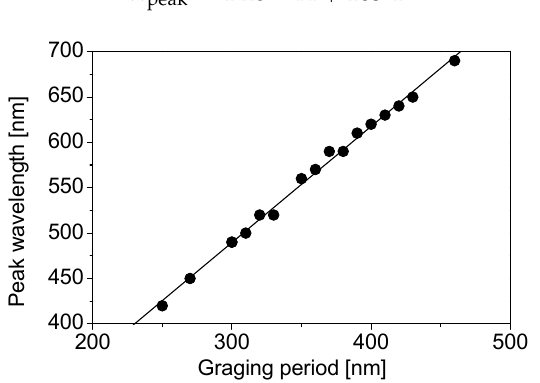
Figure 10. Dependence of the peak wavelength of the spectral sensitivity on the grating period.